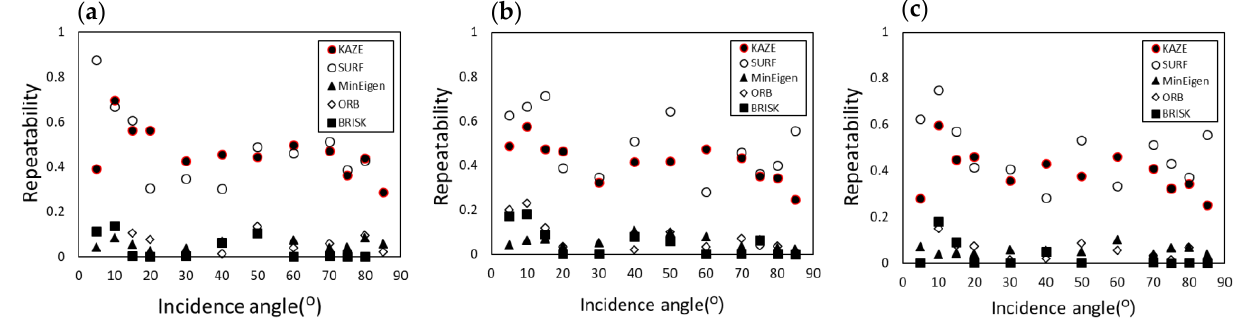
Figure 3. Repeatability of five feature matching methods. ( a ) Facing displacement; ( b ) Settlement; ( c ) Combined displacement.